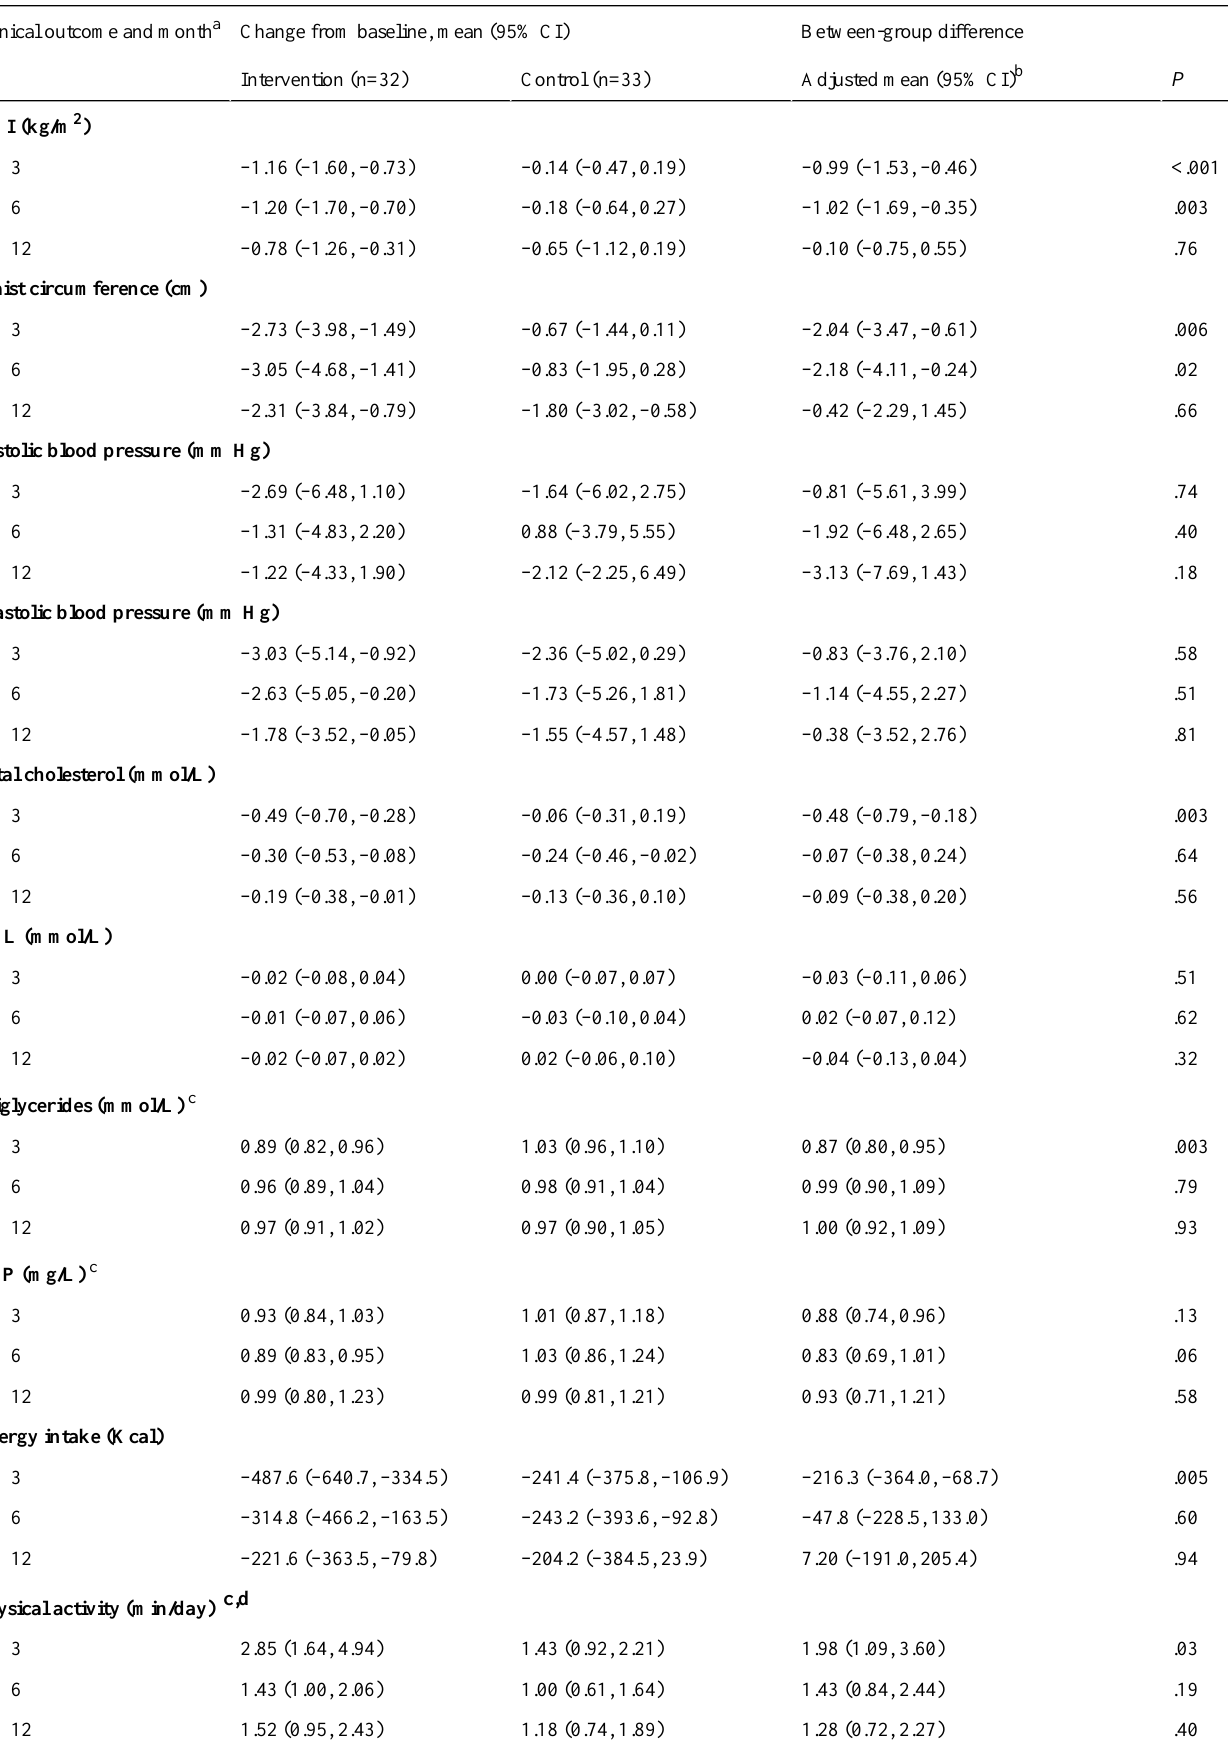
Table 4. Clinical outcome differences between study groups from baseline to 3, 6, and 12 months (intention to treat).